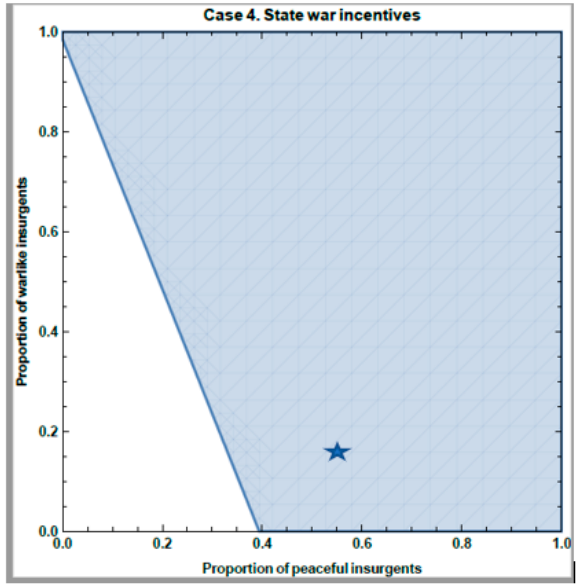
Figure 8. Fitness for State when r = 0.5, δ = 0.99, c = 0.2, and p = 0.5. For example, say initially, the State’s fitness for War was higher, so that more and more State Actors learned War, making War the fittest culture for Insurgents as well. For example, suppose that 20% of Insurgents are War type, 60% are Peace type, and 20% are Bargain type so that the system is initially at the ‘star’ in the shaded region in Figure 8. For the State then, War is the fittest culture. This means that more and more State Actors will learn War. This will increase the proportion of War types in the system, moving the system into the shaded region of Figure 7, ultimately making War the fittest type among Insurgents as well. Thus, for instance, if the increase in War type State Actors comes only at the expense of Bargaining State Actors, with no change in the proportion of Peace type State Actors (see arrow in Figure 7), the threshold where enough Insurgents learn war